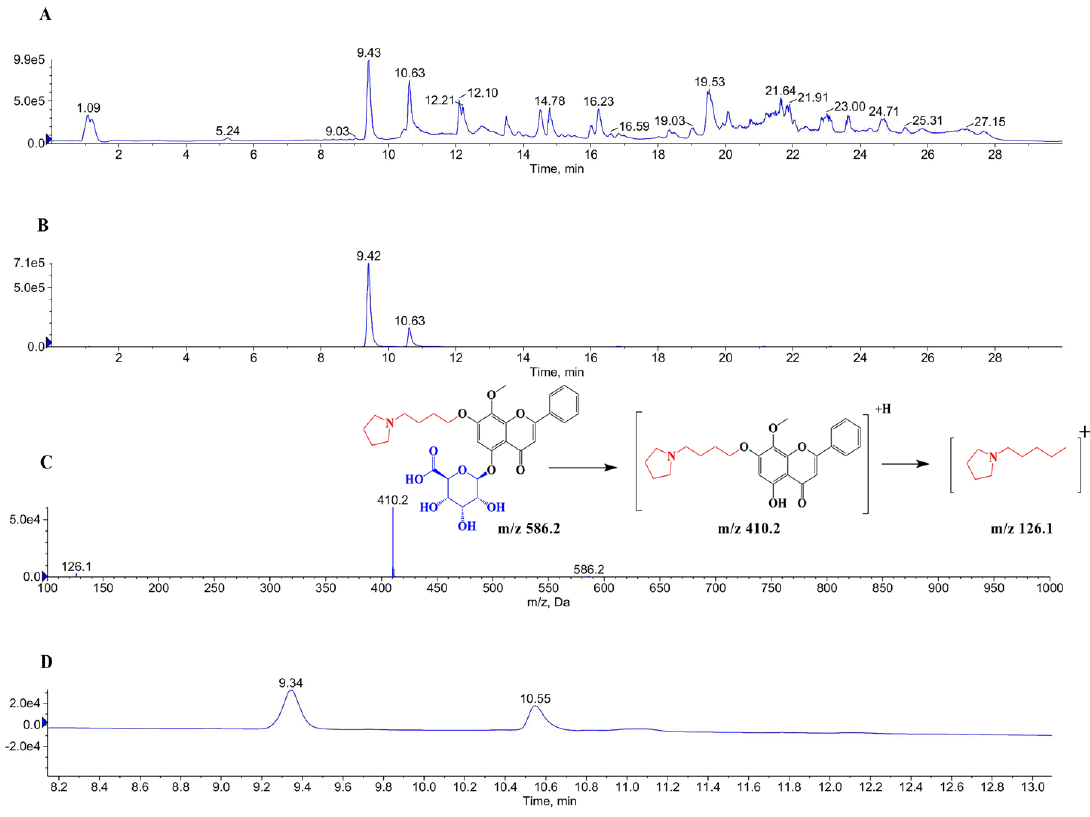
Figure 2. HPLC-UV-TripleTOF analysis of GL-V9 and metabolites in rat plasma: ( A ) Total ion current chromatogram; ( B ) extracted ion current chromatogram; ( C ) spectrum of 5- O -glucorunide GL-V9; ( D ) UV chromatogram). The structure of 5- O -glucorunide GL-V9 and predominant fragmentation pattern was shown in ( C ), and the fragment drawn in red is the chemical modification in GL-V9, while the fragment in blue is the glucuronic acid part.